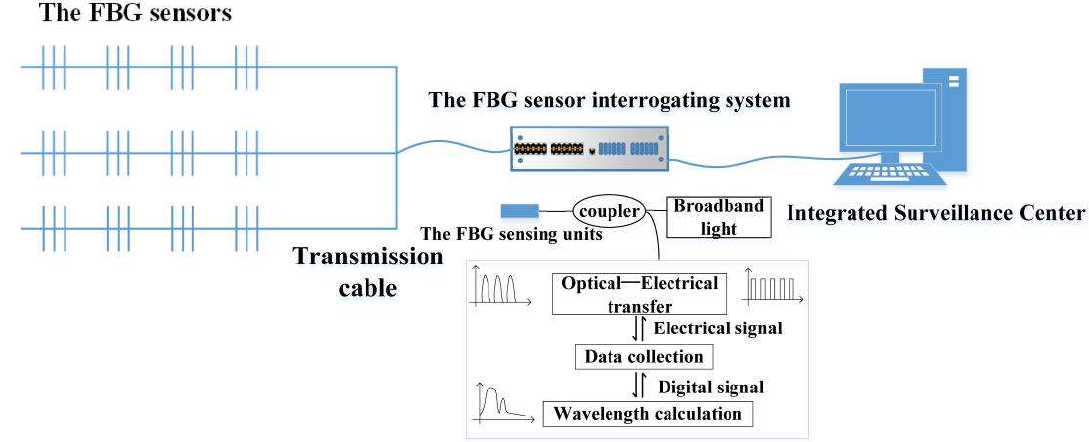
Figure 9. The FBG sensing demodulation system.